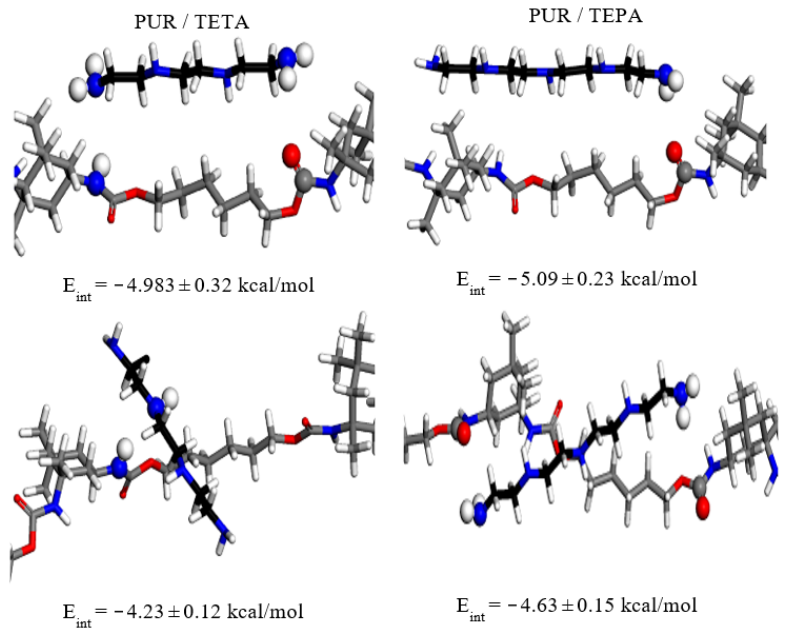
Figure 8. Mutual positions of PUR/TETA/TEPA corresponding to their maximum interaction energy for two extreme mutual positions, i.e., parallel and crossed. The atoms of the functional groups sharing hydrogen bonds are displayed as balls. For clarity, the carbon atoms in the amines are black.